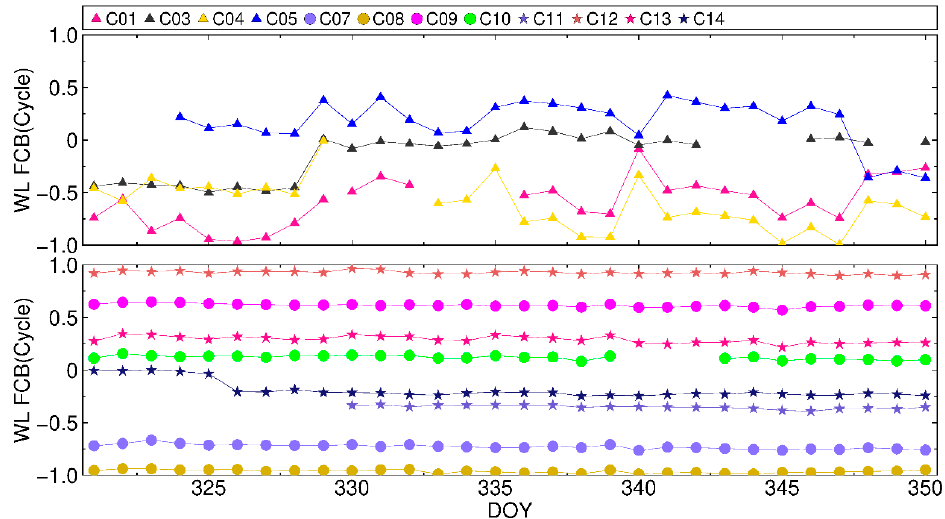
Figure 6. BDS WL FCB from DOY 321 to 350, 2018. Top panel: BDS GEO. Bottom panel: BDS non-GEO. C02 and C06 are taken as the reference for BDS GEO and non-GEO